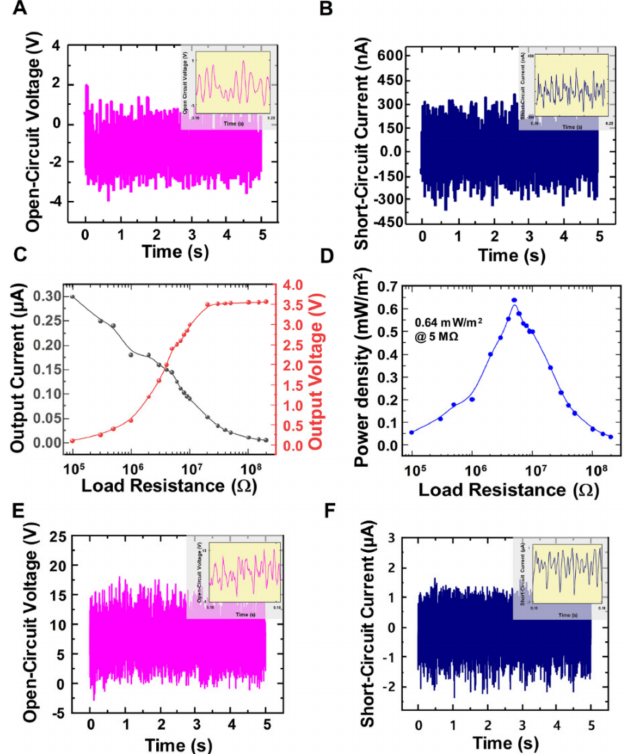
Figure 4. ( A ) Open-circuit voltage and ( B ) Short-circuit current at the minimum operating wind pressure of 0.05 MPa. ( C ) Load resistance dependency of the output voltage and current at wind pressure of 0.05 MPa. ( D ) Load resistance dependency of the output power at wind pressure of 0.05 MPa. ( E ) Open-circuit voltage and ( F ) Short-circuit current at the high wind pressure of 0.2